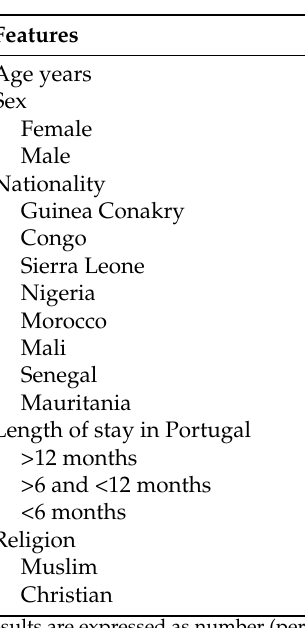
Table 2. Initial characteristics of the